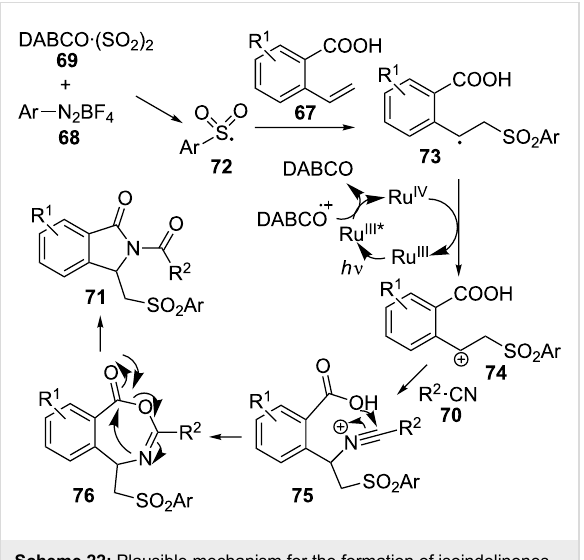
Scheme 22: Plausible mechanism for the formation of isoindolinones 71 .